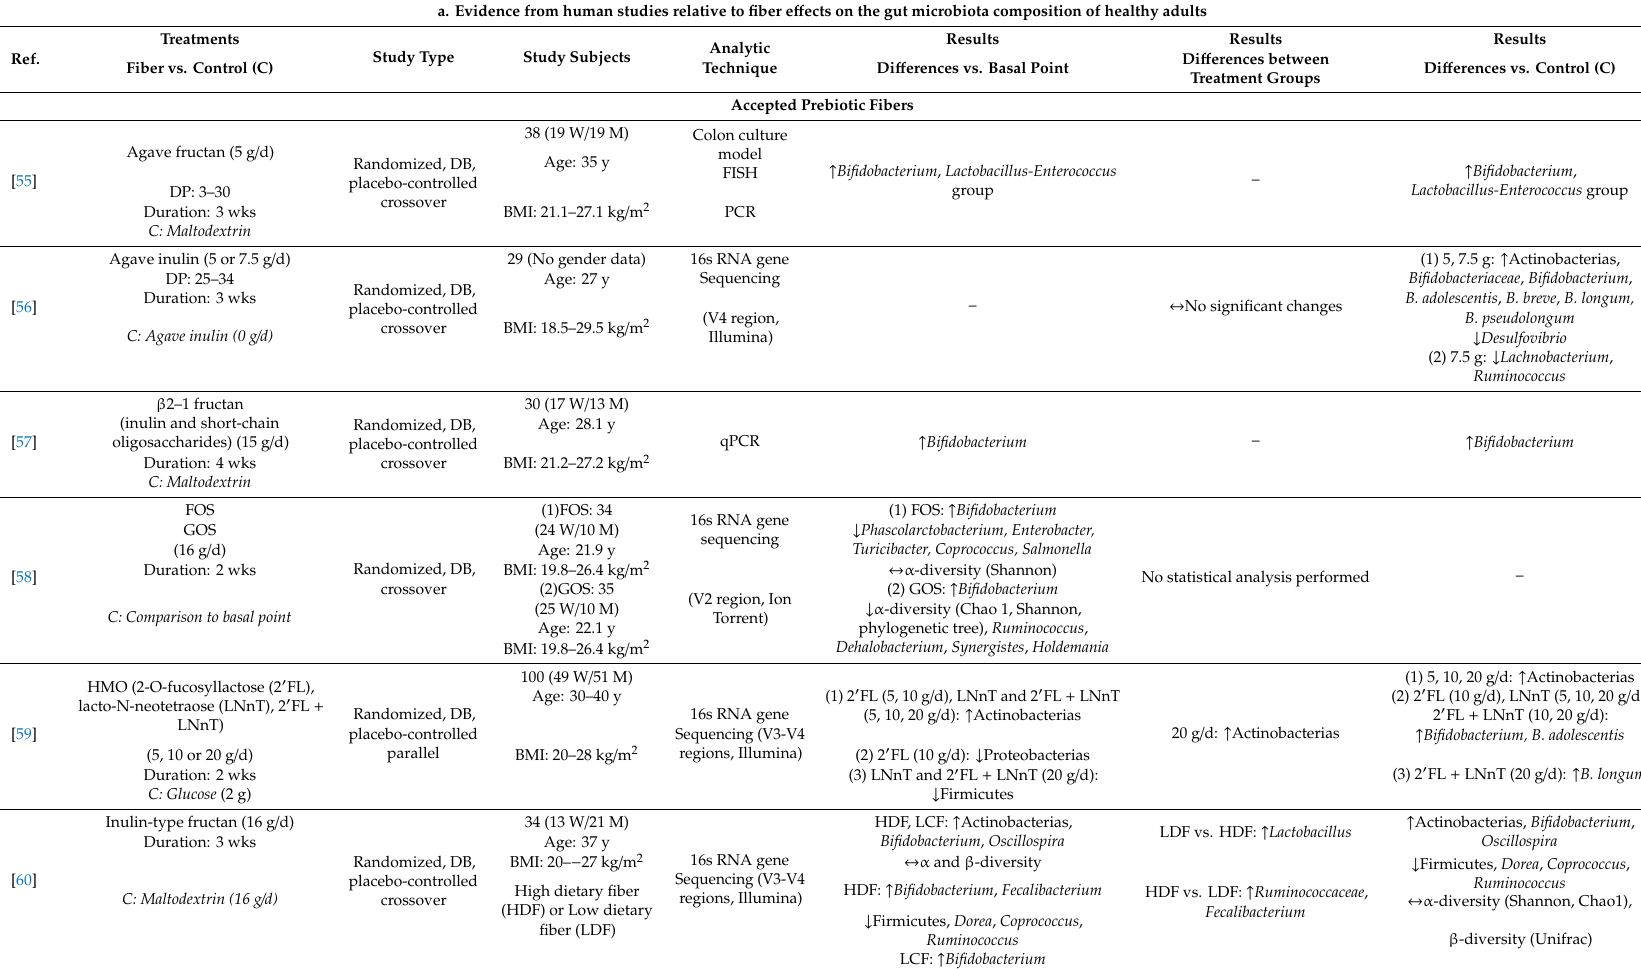
Table 2. ( a ) Evidence from human studies relative to fiber e ff ects on the gut microbiota composition of healthy adults. ( b ) Evidence from human studies relative to polyphenols e ff ects on the gut microbiota composition of healthy adults.